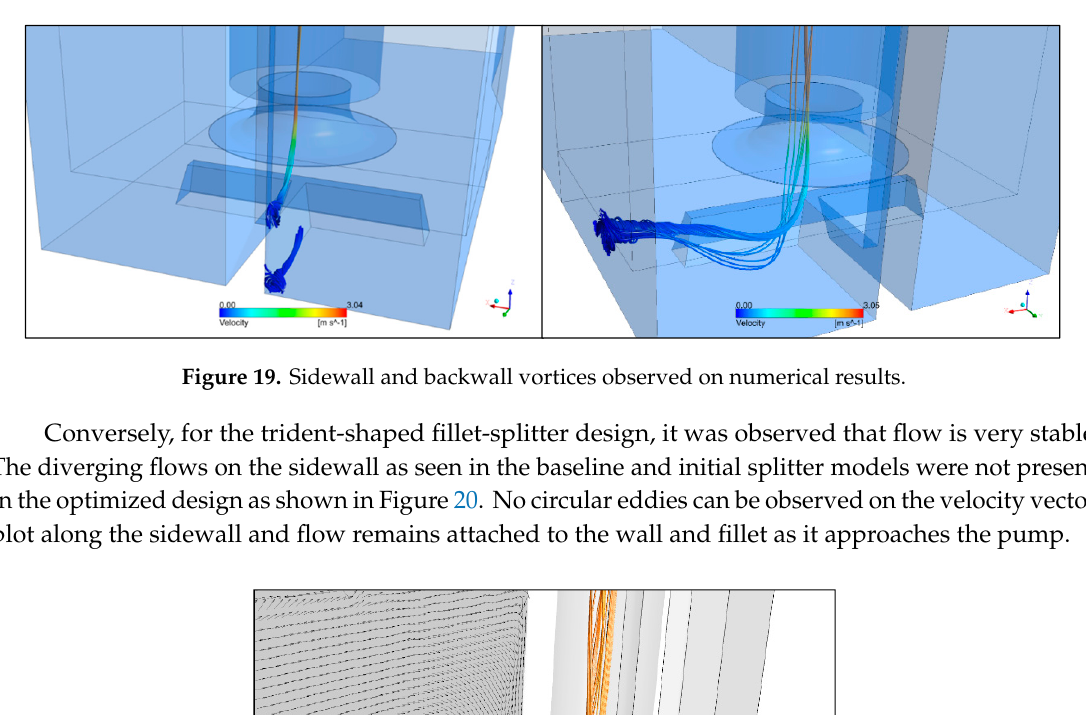
Figure 19. Sidewall and backwall vortices observed on numerical results.